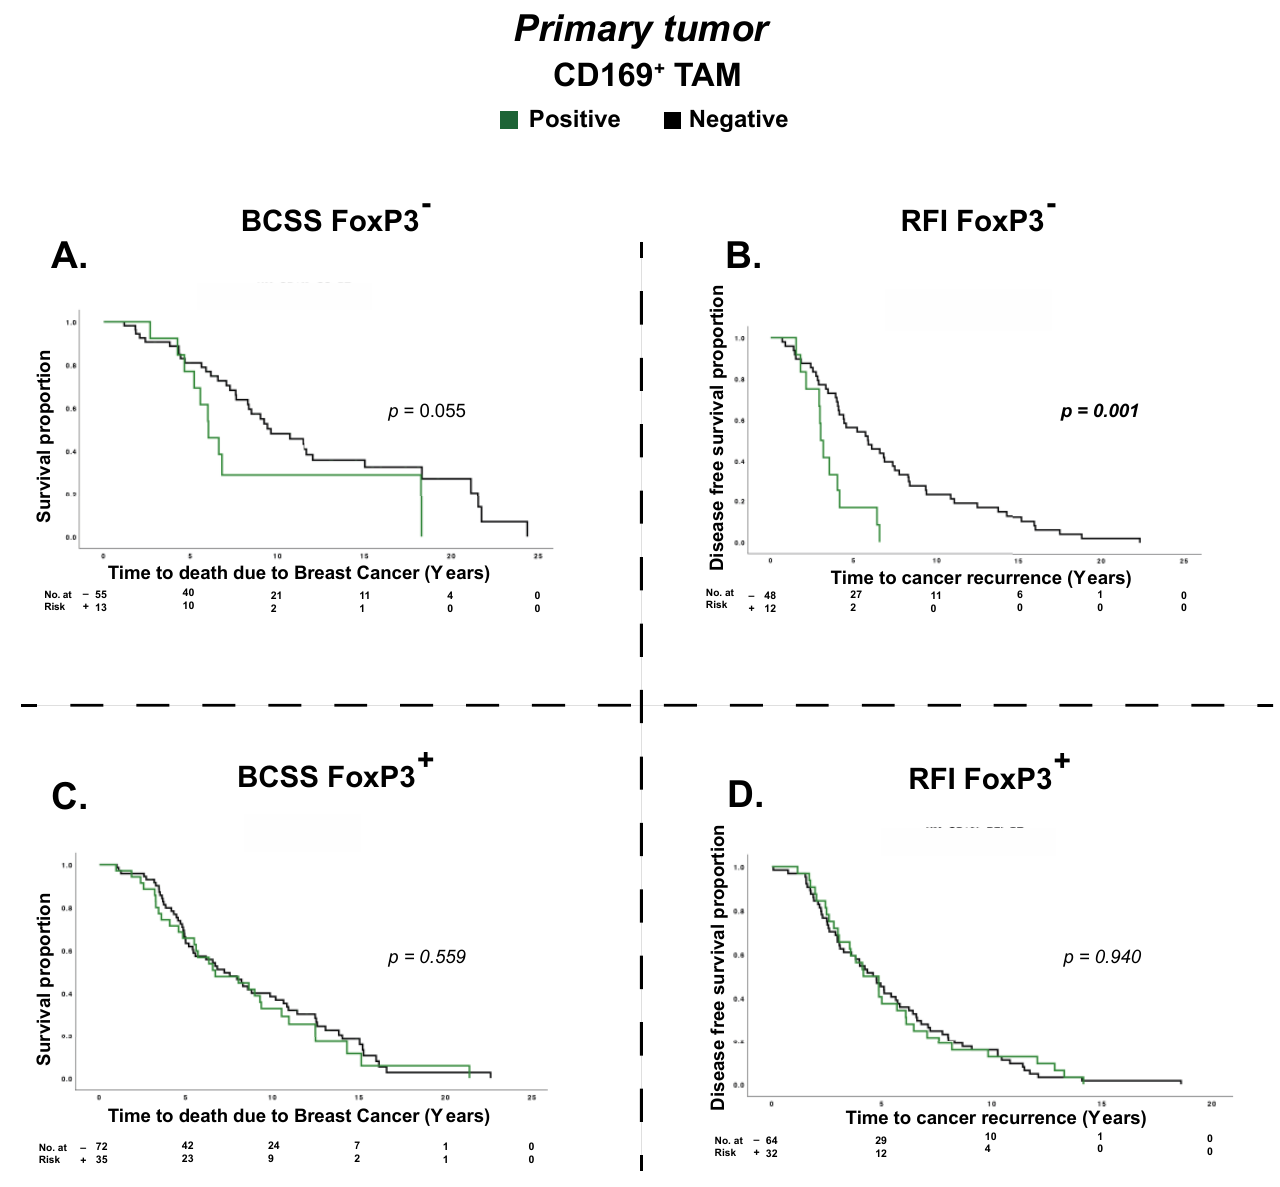
Figure 3. Kaplan–Meier survival plots with a FoxP3 strata on BCSS and RFI in PTs only. p values by the log-rank test and highlighted in bold when significant. Panels ( A , B ) show correlations for BCCS and RFI with CD169 + TAMs in FoxP3 negative cases, while panels ( C , D ) show correlations for BCCS and RFI with CD169+ TAMs in FoxP3 positive tumors. For all panels, green lines indicate PTs with CD169 + TAMs and black lines indicate patients with the absence of CD169 + TAMs.